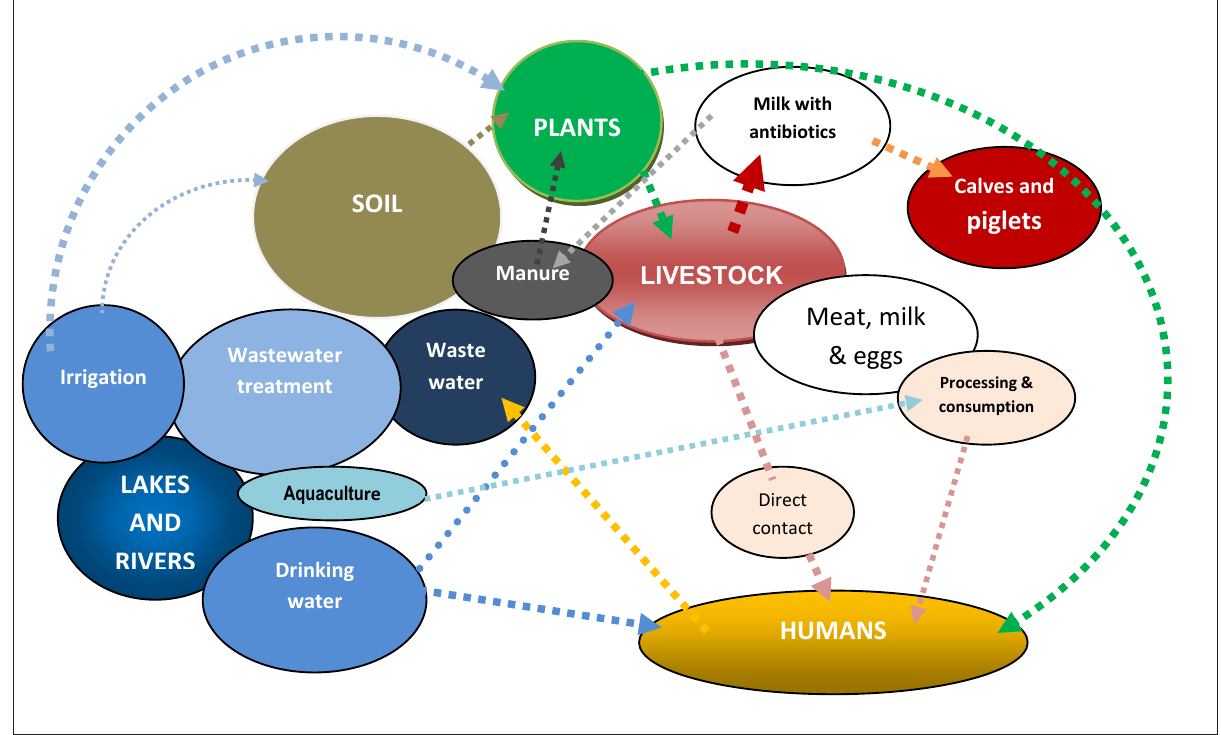
Figure 2 : Transmission pathway of antimicrobial resistance within agriculture, the Figure 2: Transmission pathway of antimicrobial resistance within agriculture, the environment and the food-processing environment and food-processing industry. Antimicrobials used in South Africa as growth promoters